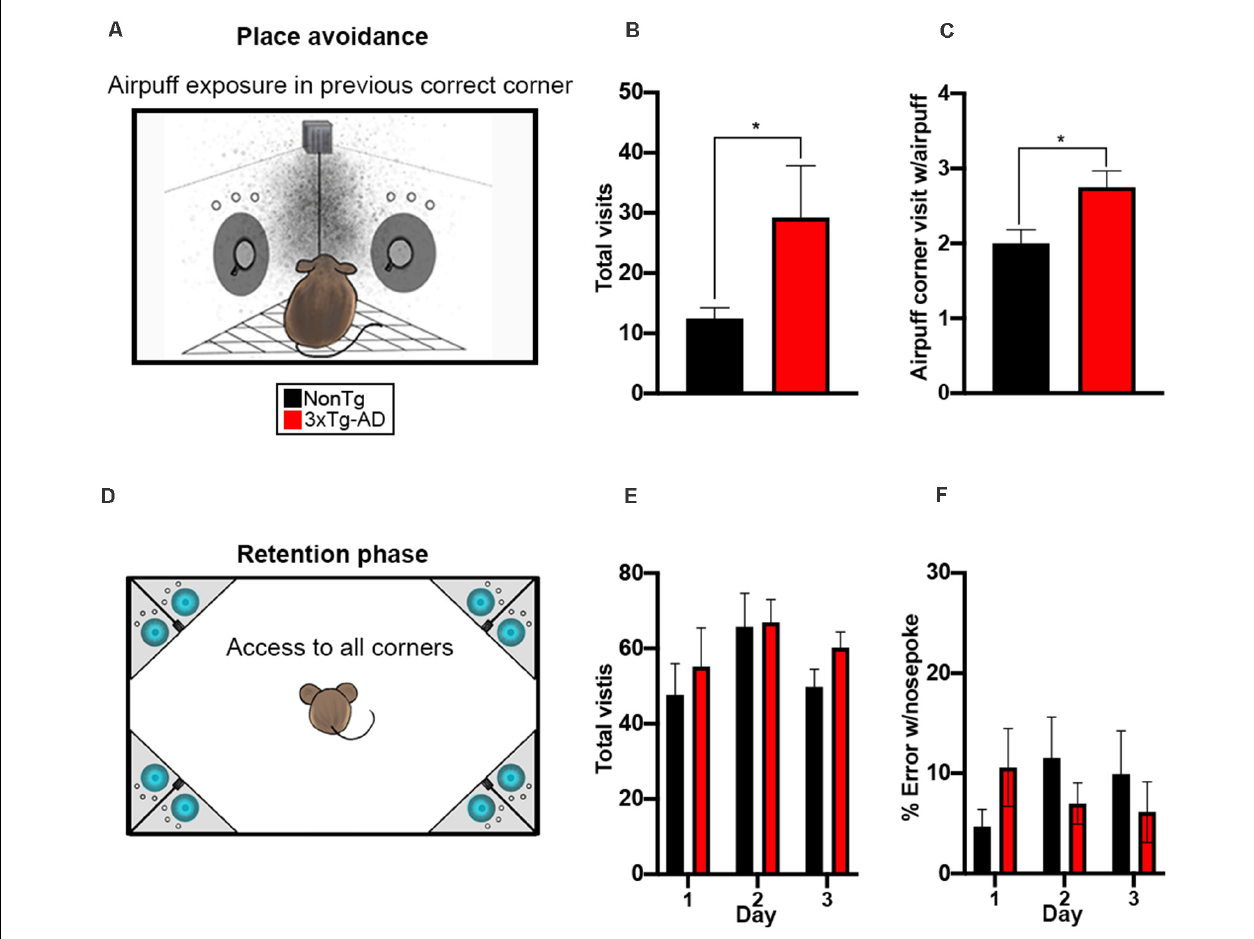
FIGURE 5 | 3xTg-AD mice show impairments in working memory during the place avoidance task. (A) For a 24-h period, entry into the assigned corner with a nosepoke resulted in an airpuff ( ∼ 0.8 bar, 1 s airpuff); cage not drawn to scale. (B,C) We found that 3xTg-AD mice made more total visits ( p < 0.05) and more visits to the airpuff corner with a nosepoke ( p < 0.05) than the NonTg mice. (D) Mice were removed from the IntelliCage after the airpuff exposure and placed in a standard cage for 24 h, then returned to the IntelliCage to assess memory and extinction by measuring corner visits to the previously assigned airpuff corner; cage not drawn to scale. (E,F) No significant differences in total visits or % error with a nosepoke (i.e., visiting the airpuff corner from exposure) were detected. Data are presented as means ± SEM. * p <